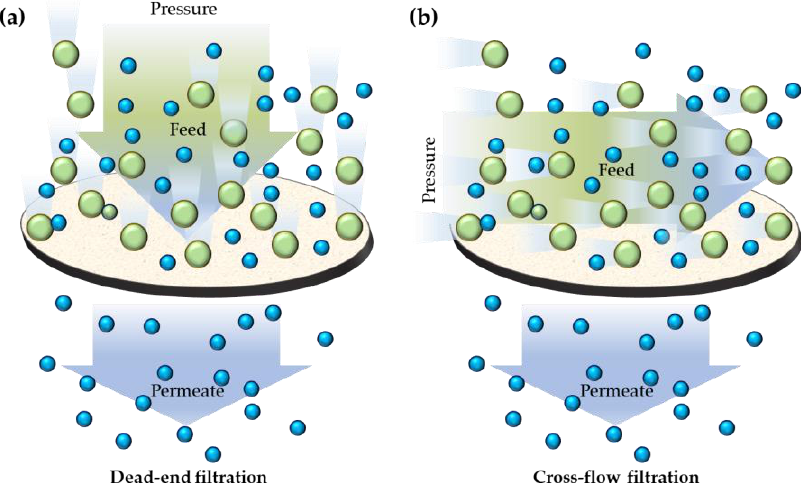
Figure 1. Schematization of dead-end ( a ) and cross-flow ( b ) filtration processes.